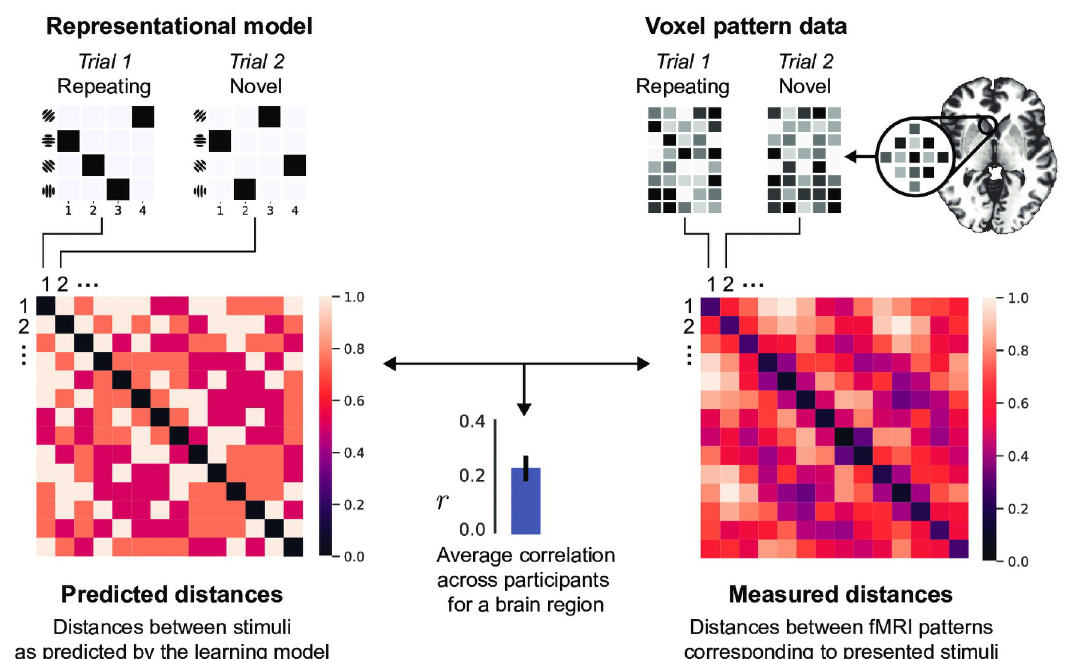
Fig 3. Testing the predictions of learning models using RSA. Left : model prediction expressed as a representational dissimilarity matrix (RDM) of pairwise between-stimulus distances (the cells in the matrix display the associative learner predictions in terms of item-position associations as quantified by the Hamming distance). The small matrices on the top refer to the representations of individual sequences in the matrix form (as shown on Fig 1). For example, second cell in the first row is the predicted Hamming distance between sequences presented on trials 1 and 2. Right : RDM of measured voxel activity patterns elicited by the stimuli. The small matrices are illustrative representations of voxel patterns from an arbitrary brain region. The correlation between these two RDMs reflects the evidence for the predictive model. The significance of the correlation can be evaluated via permuting the labels of the matrices and thus deriving the null-distribution. See Representational similarity analysis (RSA) in Methods for details.